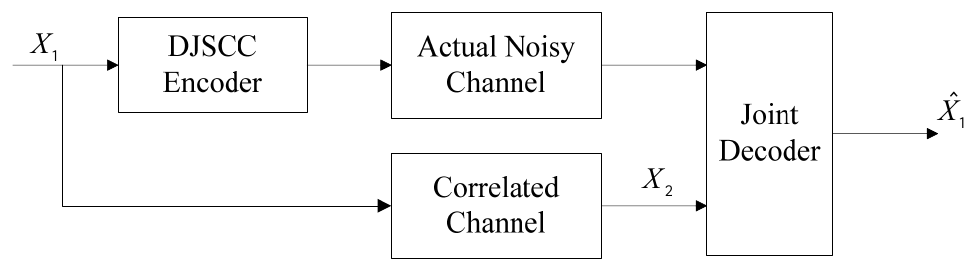
Figure 1. The system model of DJSCC for the asymmetric